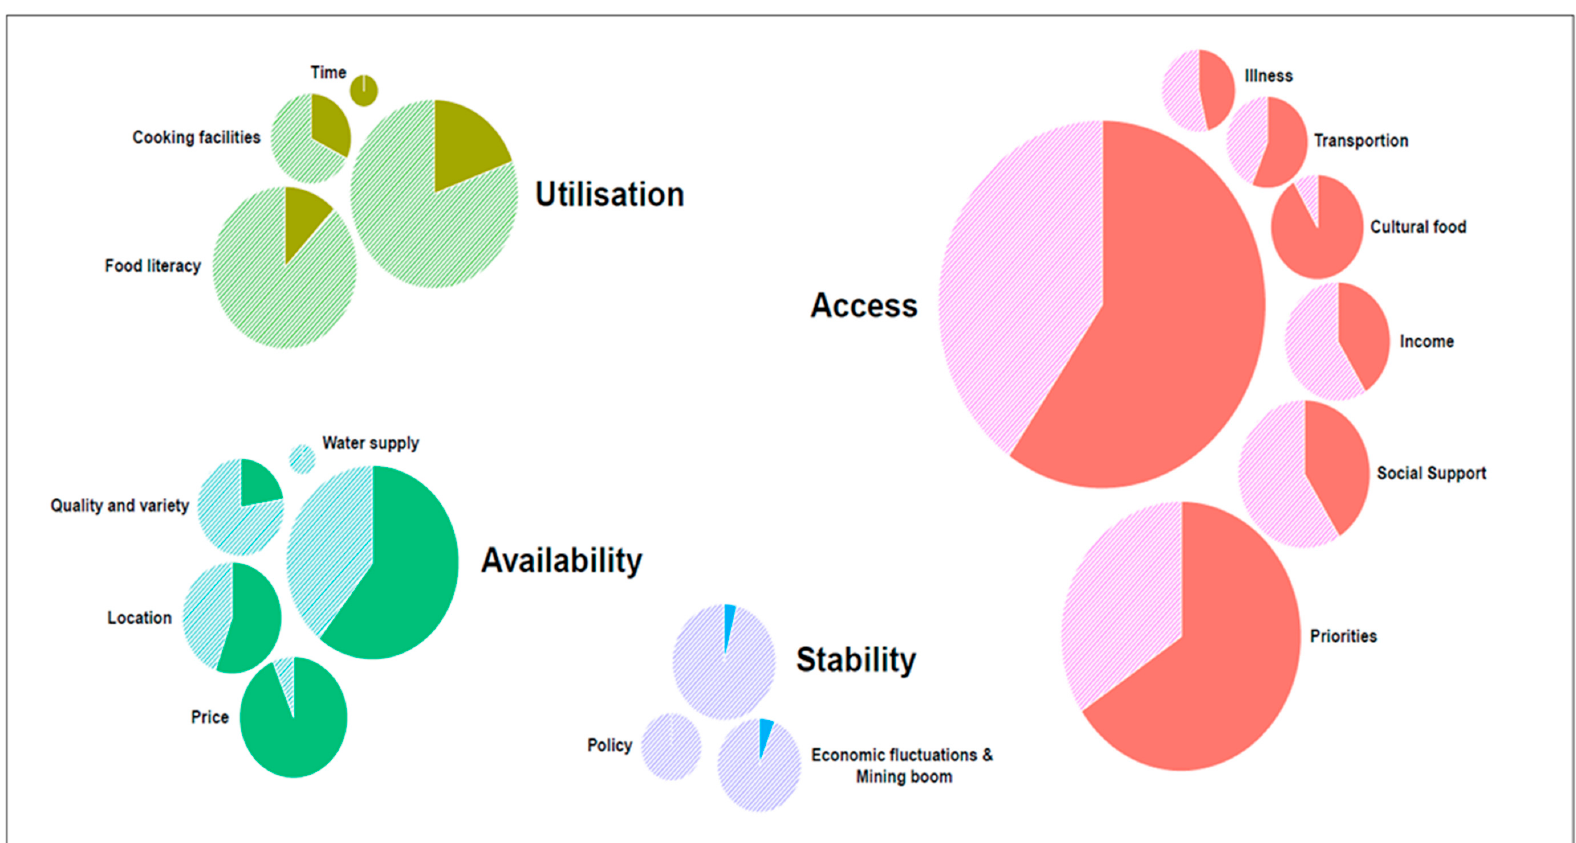
Figure 1. The proportions of the food insecurity drivers cited by stakeholders and at-risk group. The size of the circle indicates the frequency of the driver cited. An even distribution of solid and striped colours indicates that the driver was cited equally by stakeholders and at-risk individuals. A larger proportion of solid colour indicates that the driver was more frequently cited by at-risk individuals than stakeholders, and vice versa.